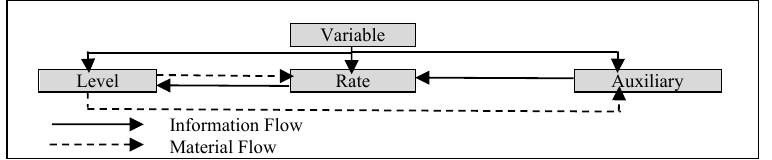
Fig. 1. Types of System Dynamic Models (Sterman,